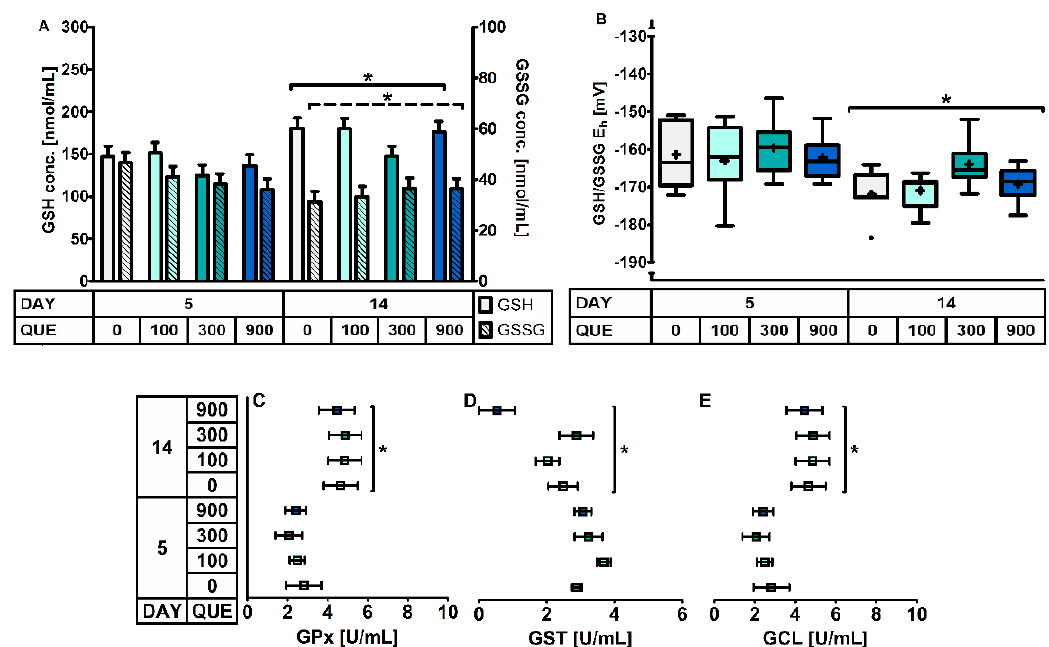
Figure 1. The glutathione redox system in blood of piglets at d5 and d14 post-weaning (DAY), fed a diet containing 0, 100, 300, or 900 mg quercetin / kg diet (QUE) during the first 14d post-weaning. Results are presented as least squares means with SD. Significance levels of main e ff ects and interaction terms are presented in Table 4: ( A ) glutathione (GSH) and glutathione disulphide (GSSG) concentrations in erythrocytes; ( B ) Glutathione redox status (GSH / GSSG E h ) in erythrocytes; ( C ) Glutathione peroxidase (GPx) activity in plasma; ( D ) Glutathione transferase (GST) activity in plasma; ( E ) Glutamate-cysteine ligase (GCL) activity in plasma. * Represents the e ff ect of DAY across other factors ( p ≤ 0.05).